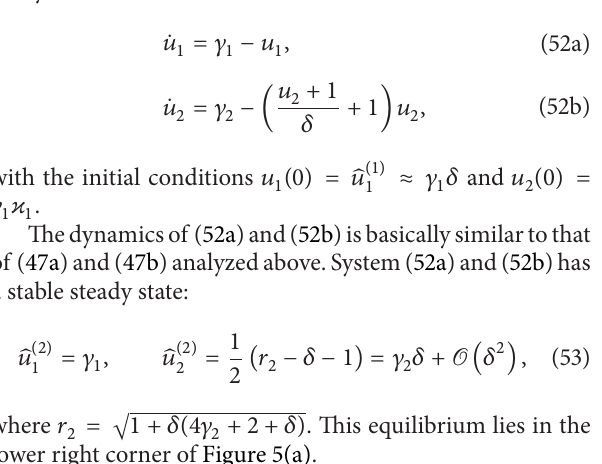
(Figure 6(a)) or via damped oscillations according to equa-